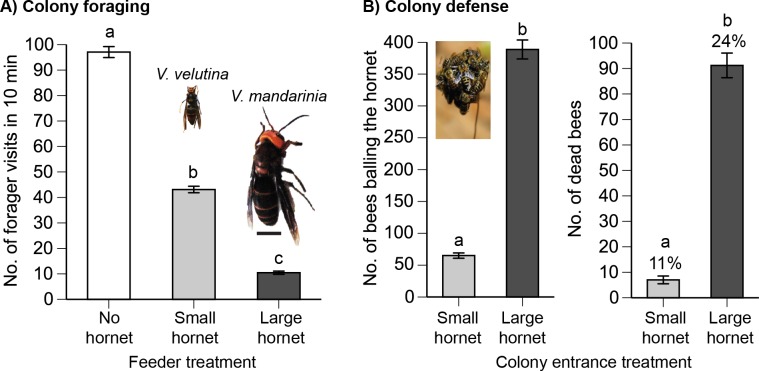
Effects of hornet attacks upon colony foraging allocation and defense.In both contexts, larger hornets were more dangerous. (A) The large hornet elicited the greatest colony foraging aversion (six trials/treatment/colony for a total of 54 trials). Scale bar is 1 cm. Different letters indicate significant differences (Tukey’s Honestly Significant Difference [HSD] test, p < 0.05). (B) When it attacked the colony, the large hornet was balled by 6-fold more bees, and 13-fold more of these bees died (percentage dead also shown, three trials/treatment/colony for a total of 18 trials). An image of bees balling the small hornet is shown. Different letters indicate significant differences. Graphs show the mean ± 1 standard error.